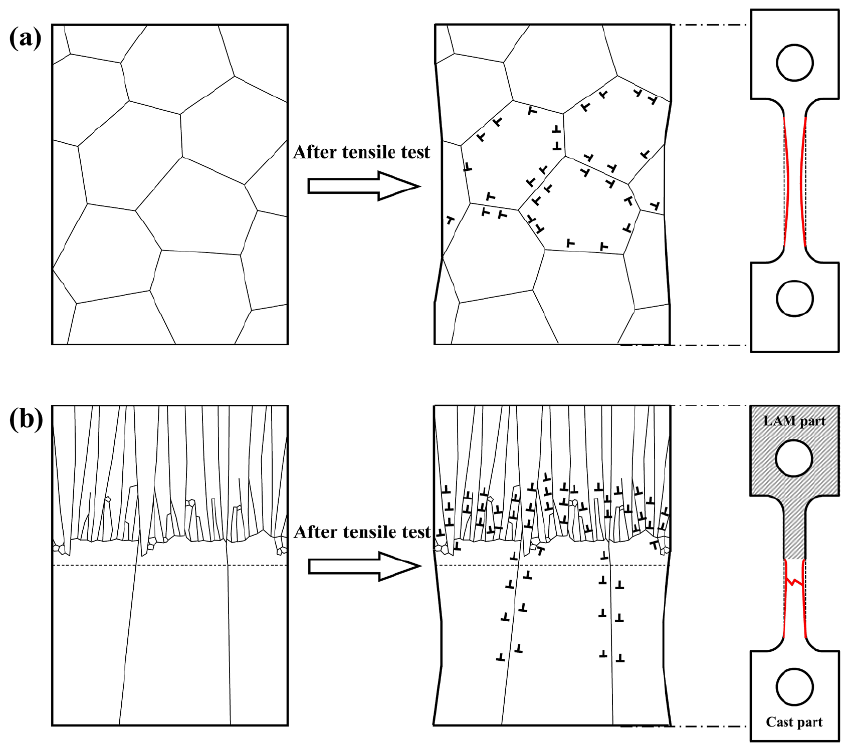
Figure 9. Schematic diagrams illustrate the fracture mechanism of ( a ) the pure casting sample and ( b ) the hybrid sample.